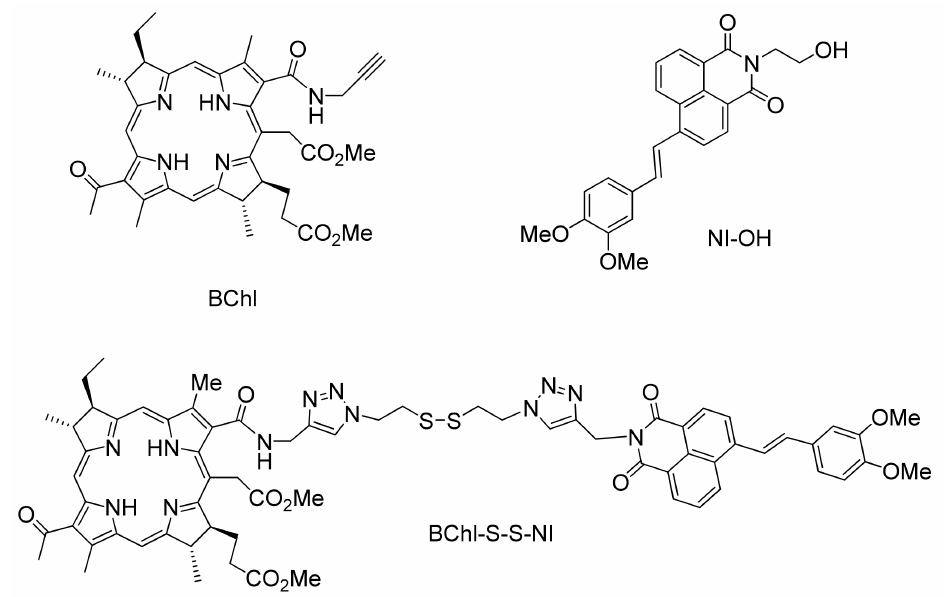
Figure 1. Structures of photosensitizer BChl, fluorescent dye NI–OH and conjugate